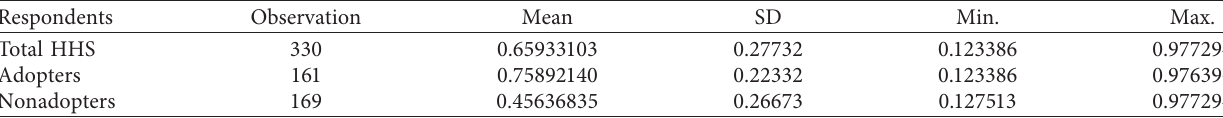
Table 8: PS distribution after selecting the common support